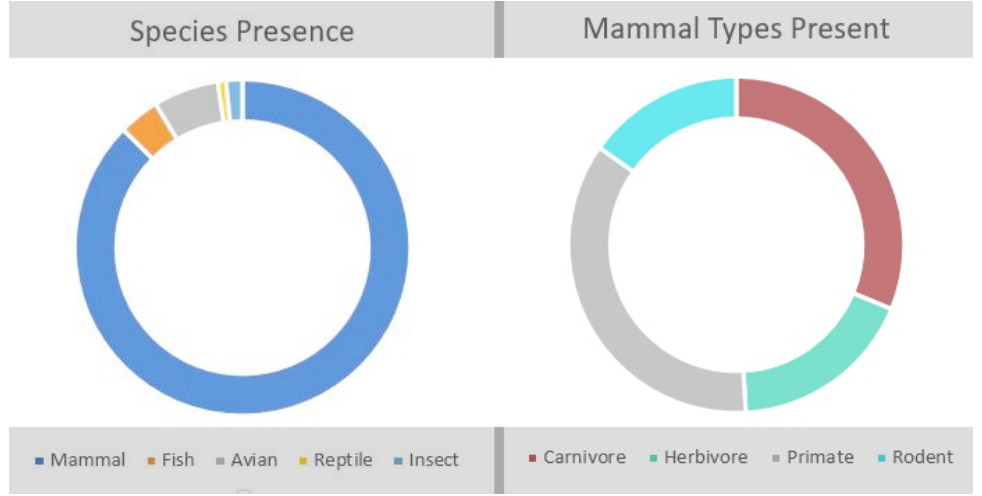
Figure 2. The prevalence of species in the